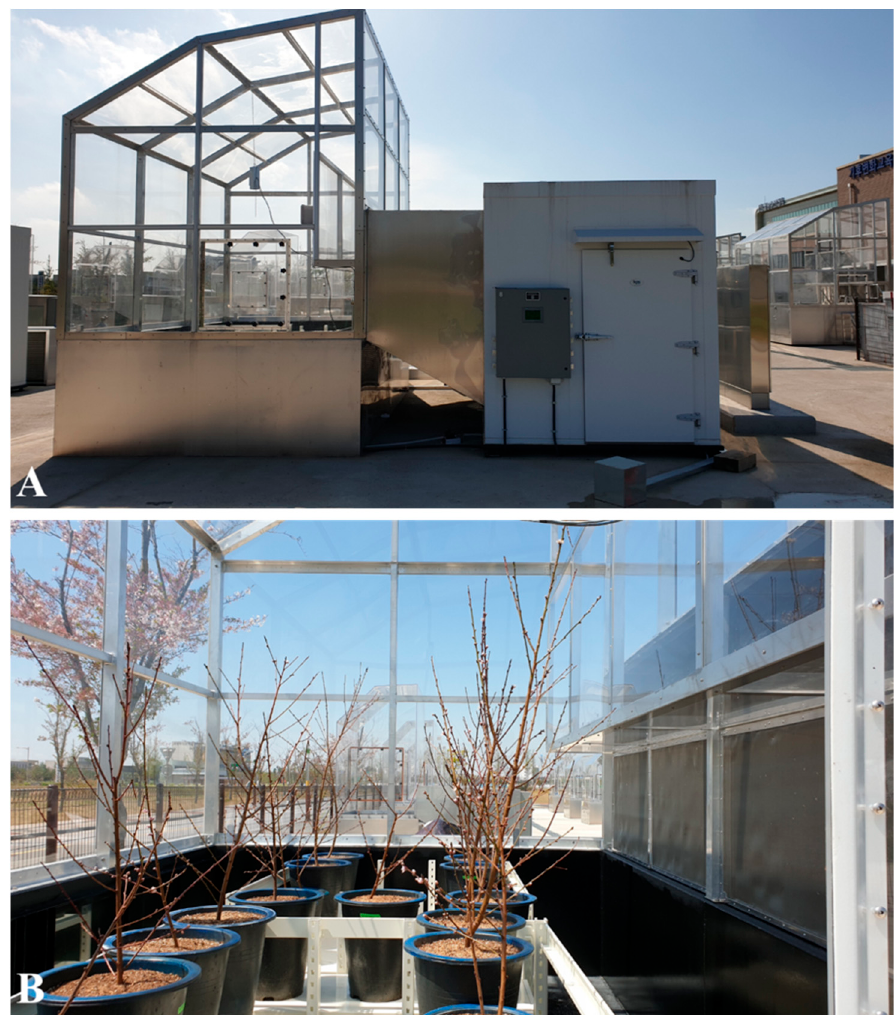
Figure 4. A front view of an SFDS chamber ( A ) and 2-year-old ‘Daewol’ peach trees placed in the SFDS chamber ( B